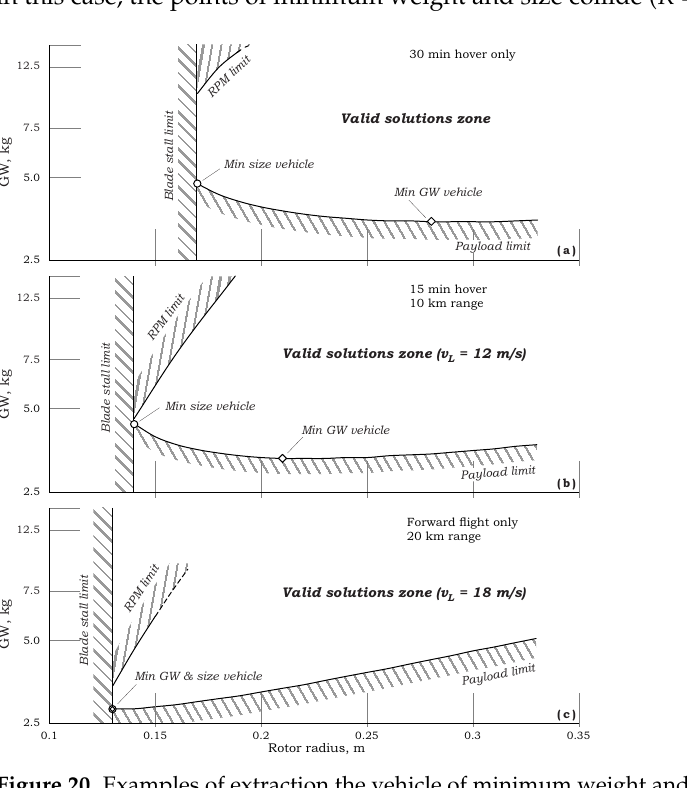
Figure 20. Examples of extraction the vehicle of minimum weight and the vehicle of minimum size for various missions and loiter velocities (payload ≥ 1.